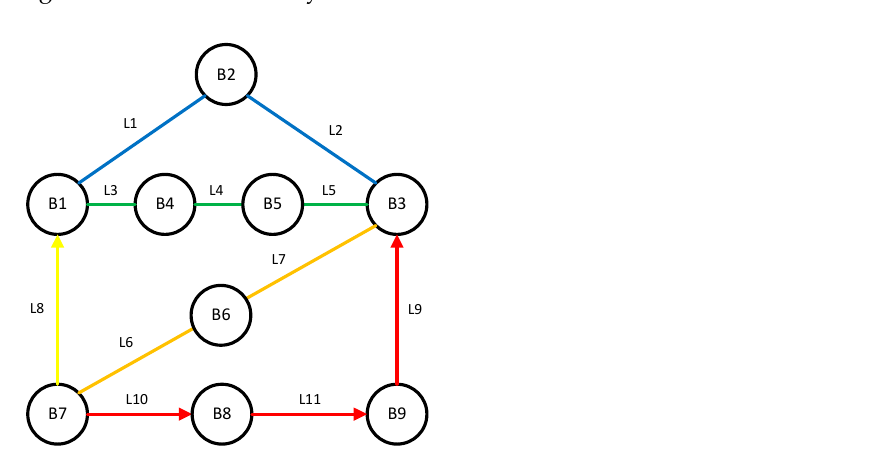
Figure 3. Schematic diagram of the test microgrid (MG).